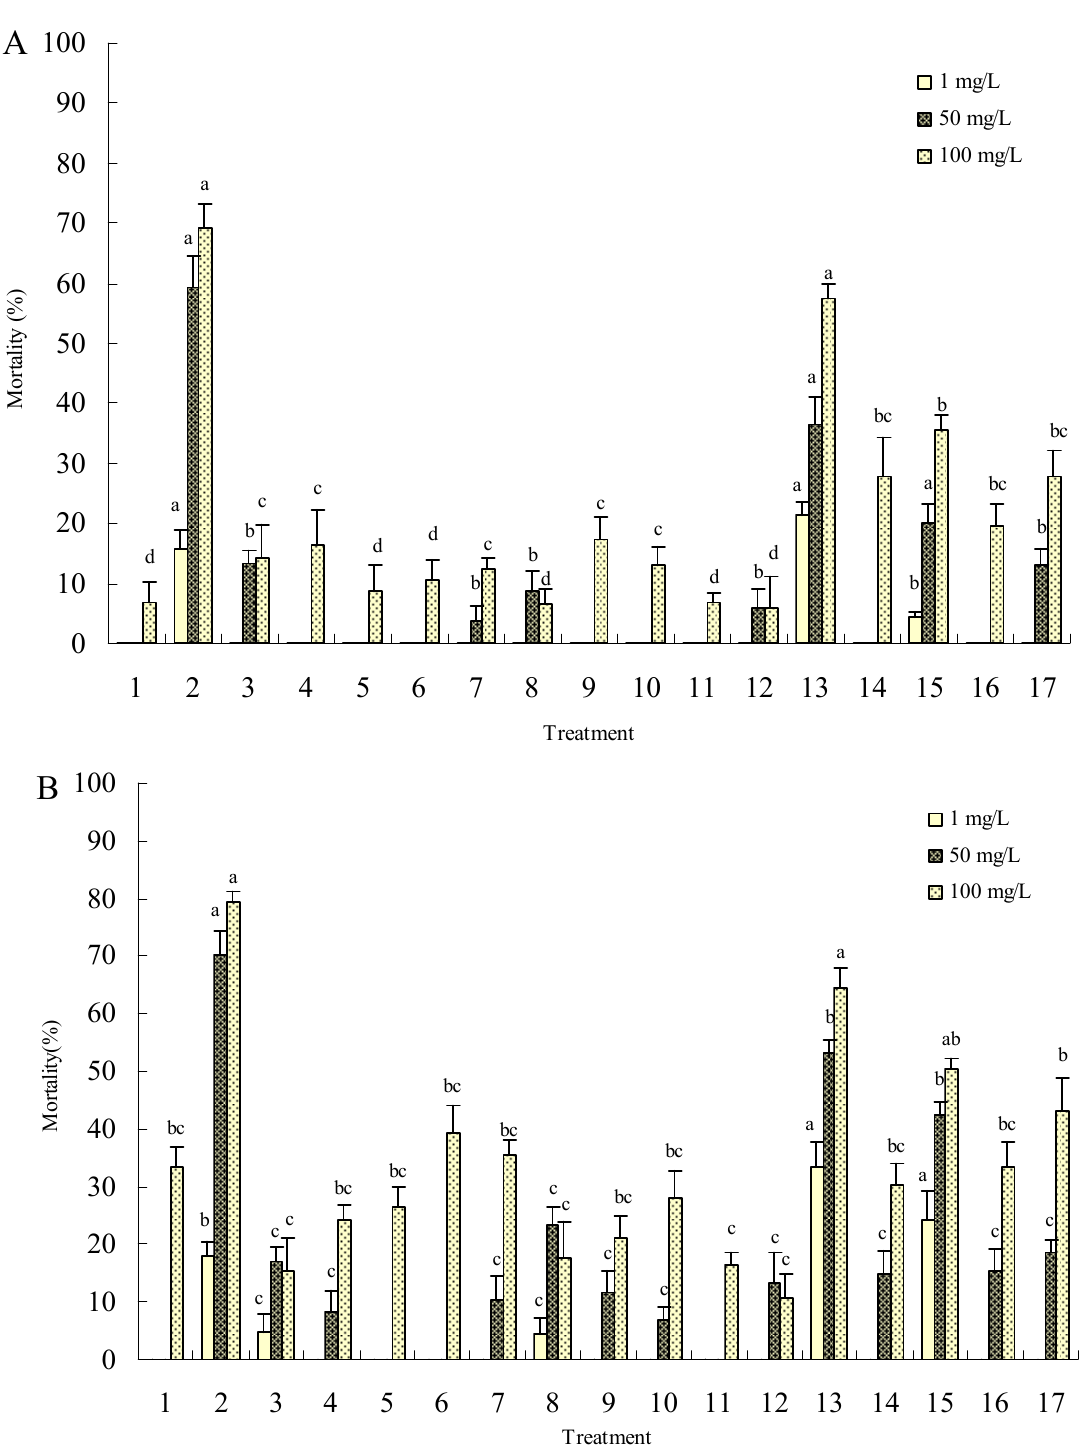
Figure 2. Mosquitocidal effect of compounds 1-16 against 4th instar mosquito ( Cx. pipiens quinquefasciatus ) larvae. A is the effect of 2 h treatment; B is the effect of 12 h treatment; C is the effect of 24 h treatment. Treatments 1-16 are the synthesized compounds and treatment 17 is harmine, a positive control. The error bars represent mean±SEM for data derived from three independent experiments. Mean values followed by the same letter above bars have no significant difference (P ≤ 0.05) according to Duncan’s multiple-range